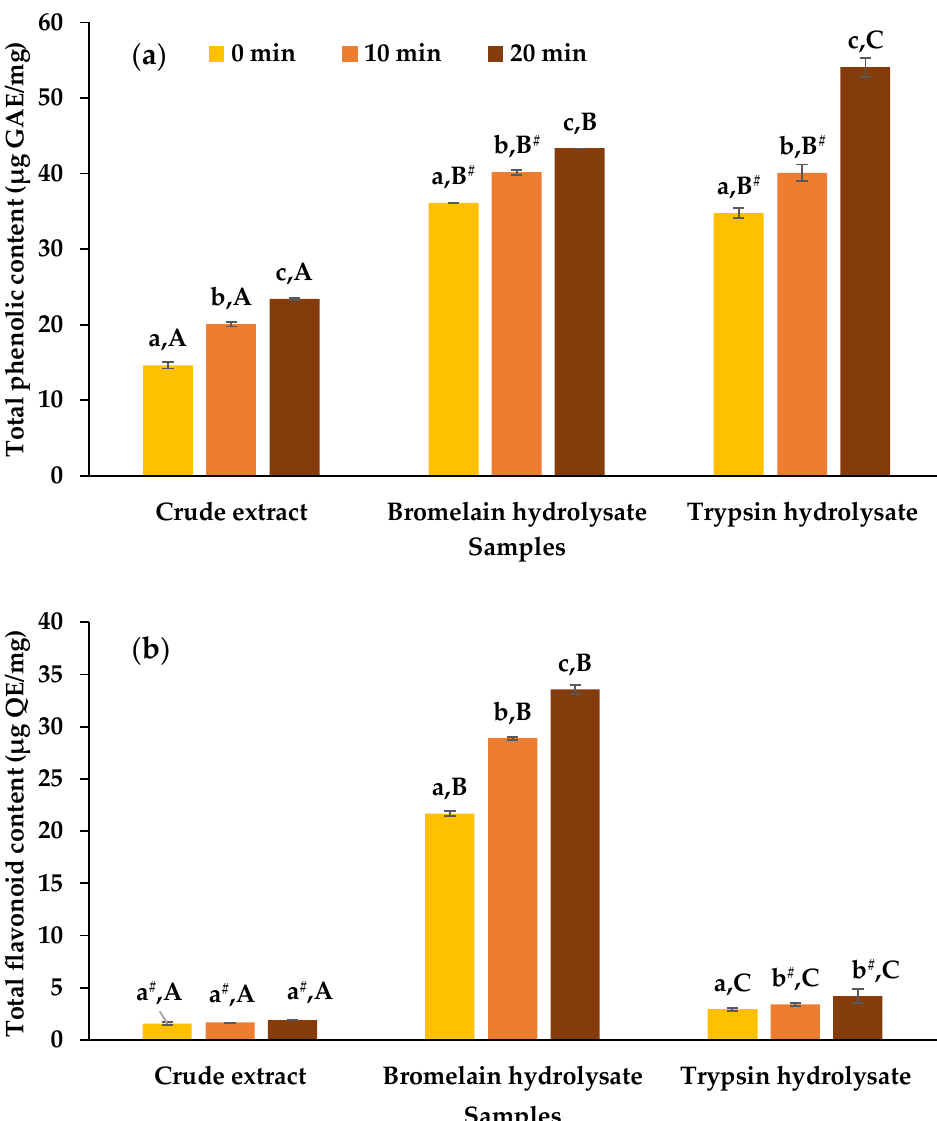
Figure 2. Total phenolic content ( a ) and total flavonoid content ( b ) in crude extracts, bromelain hydrolysates, and trypsin hydrolysates of raw and roasted butterfly pea